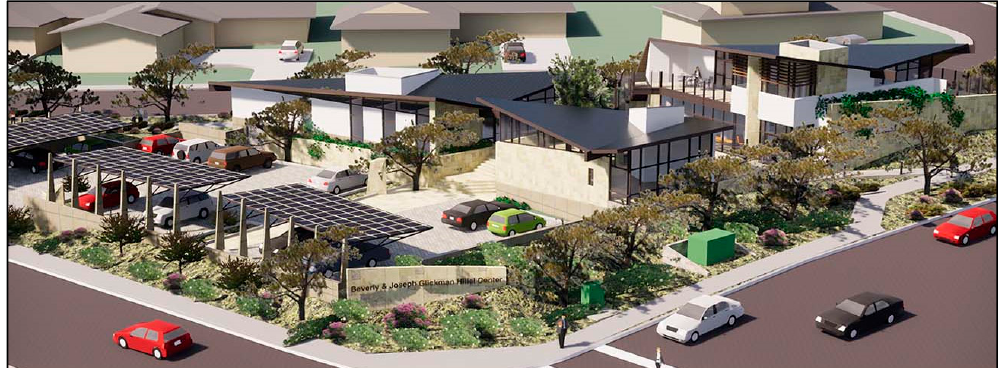
Figure 17. Digital Visualization: Aerial View of Glickman Hillel Center at UCSD, seen from North East. Image Credits: © M. W. Steele Group, used by permission.